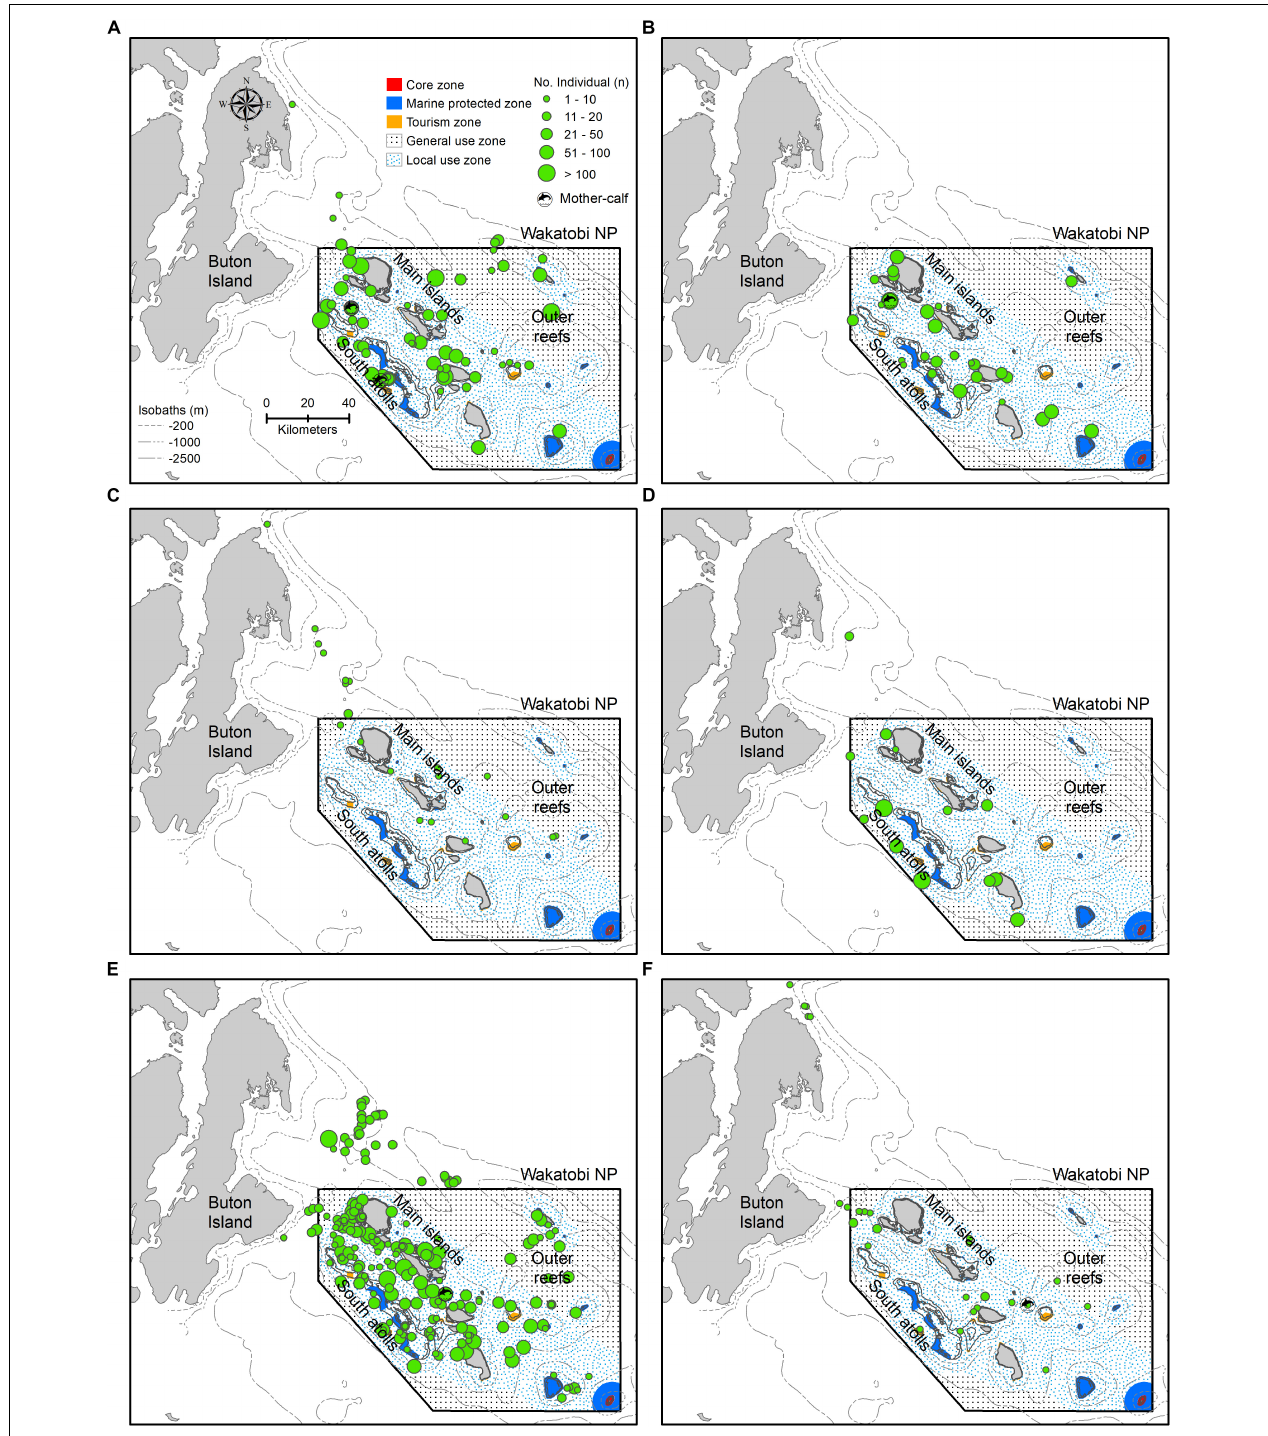
FIGURE 3 | Spatial occurrence patterns of cetaceans in Wakatobi based on sightings in the period of May 2004 to May 2012: (A) Bottlenose dolphin, (B) Spinner dolphin, (C) Sperm whale, (D) Melon-headed whale, (E) Unidentified dolphins, and (F) Unidentified whales. The depth contours (isobaths) and Wakatobi National Park (WNP) zoning system are presented in panel (A)